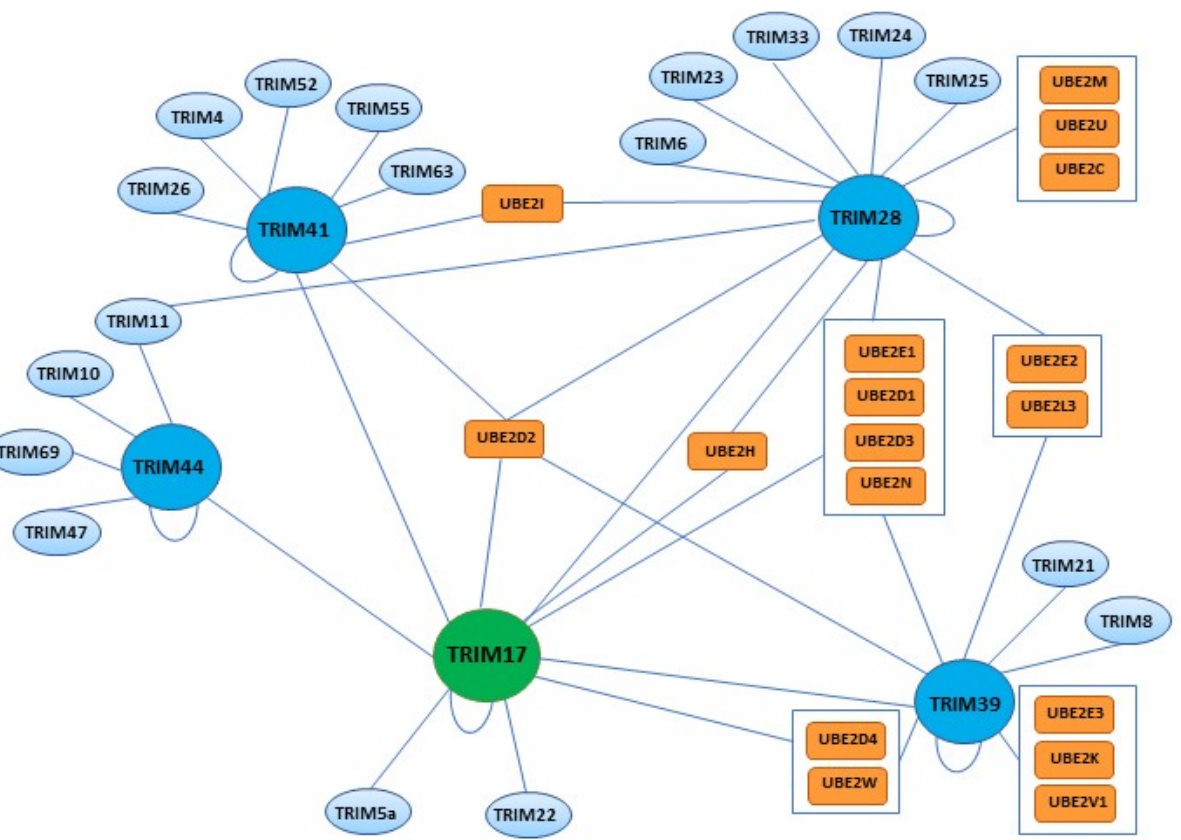
Figure 7. TRIM and E2 partners of TRIM17 from experimental data.